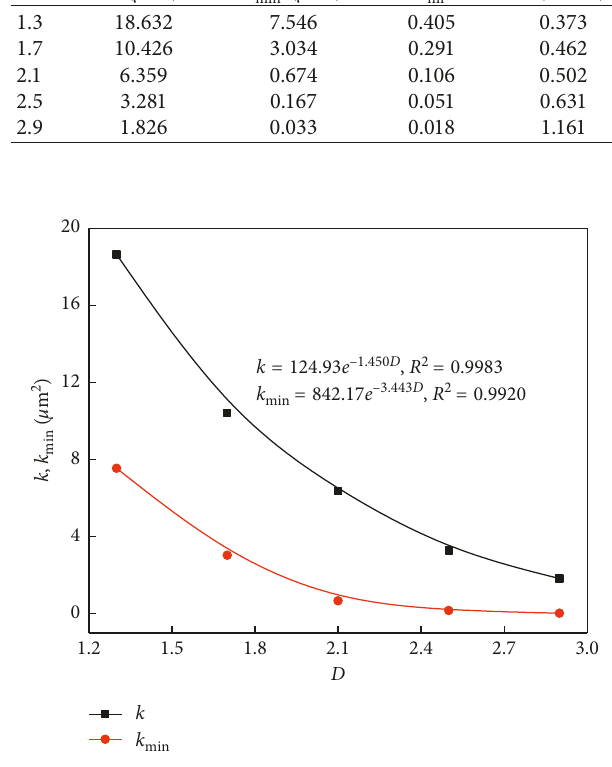
Figure 12: The variation of permeability k and the minimum permeability ratio k with the variation of fractal dimension. min